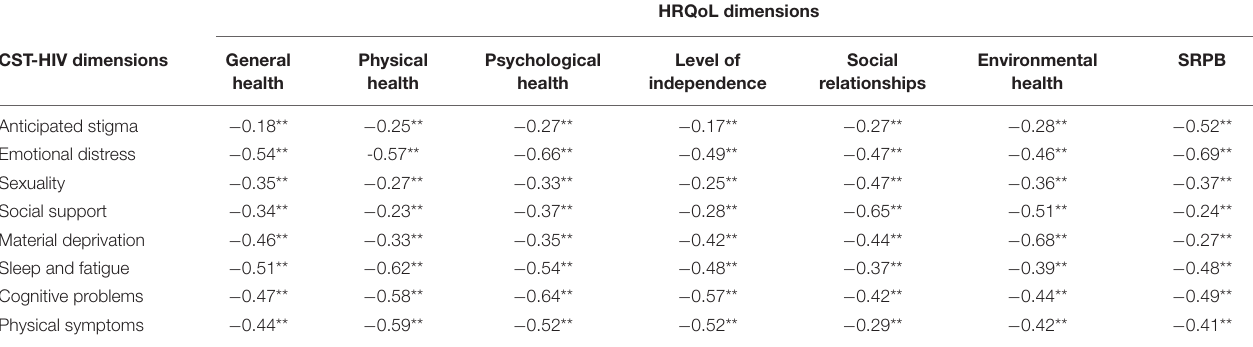
HRQoL dimensions